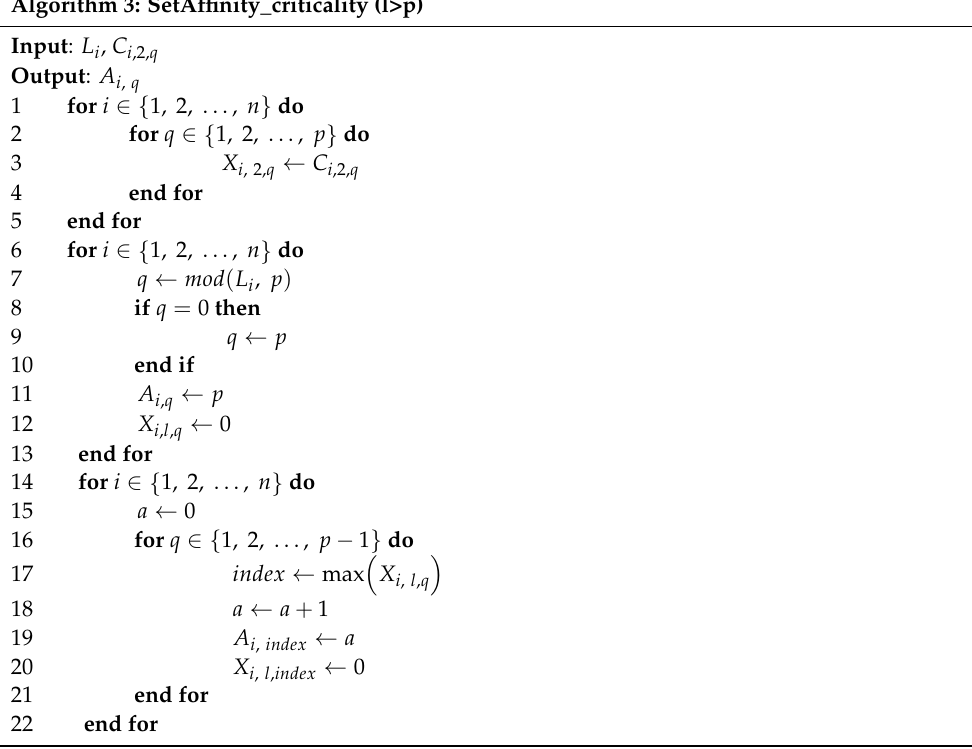
Algorithm 3: SetAffinity_criticality